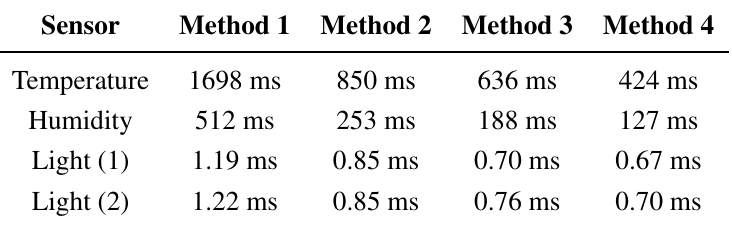
Table 2. Time required to collect one byte of entropy from the analyzed sensors with particular harvesting